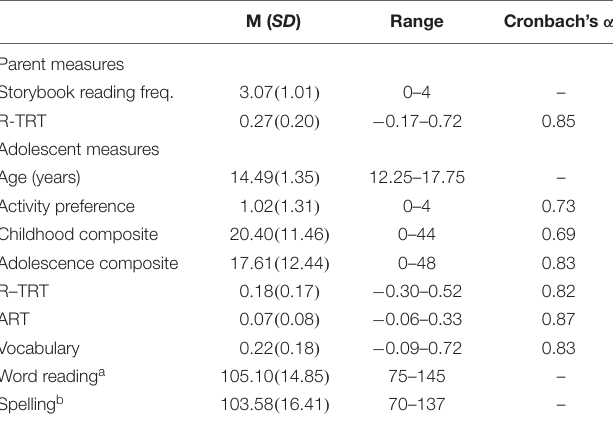
TABLE 1 | Descriptive statistics for parent and adolescent